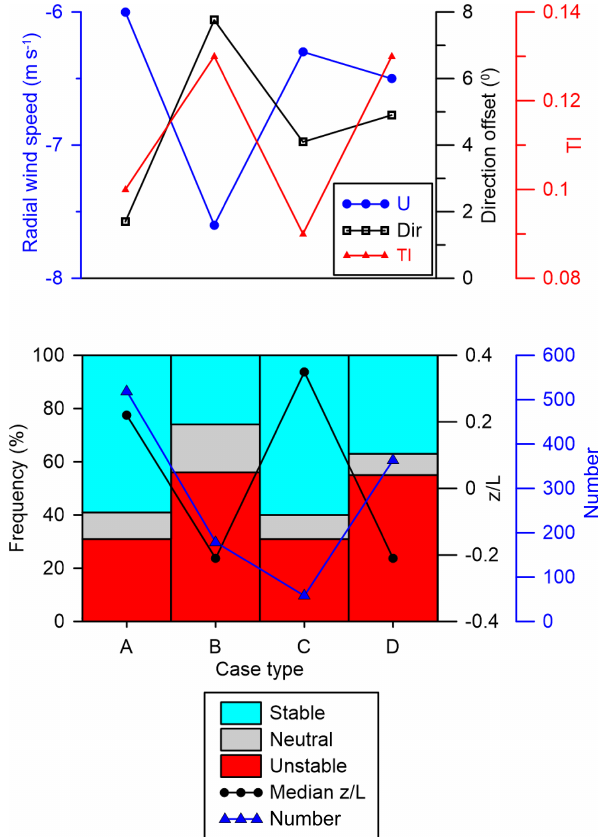
Figure 13. Mean inflow conditions and stability conditions condi- tionally sampled by wake type, where A is clear wake centre, with location being identified, B is split wake with no well-defined centre or multiple centres, with location being identified, C is clear wake centre, with location being missed, and D means that it is not pos- sible to identify a wake centre. Stability is classified based on z/L from 78m height from Tower 20, where stable z/L >0.08, unsta- ble z/L < − 0 . 08 and neutral z/L < | 0 . 08 | . Top: mean radial wind speed, turbulence intensity and direction difference from 227 ◦ by wake type. Bottom: frequency of stability conditions and the me- dian value of z/L in each wake type. Lines joining the types are to aid clarity.